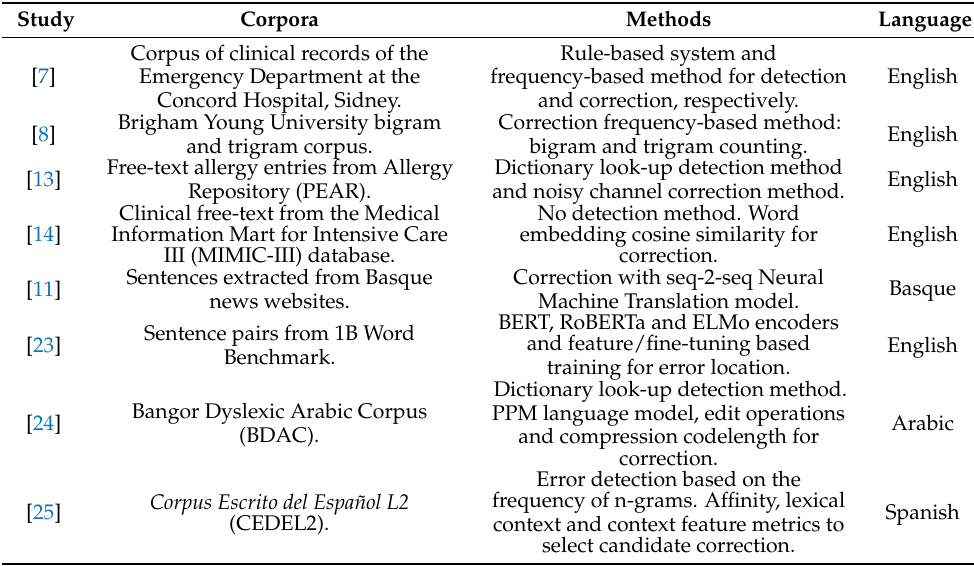
Table 1. Corpora and methods used in each